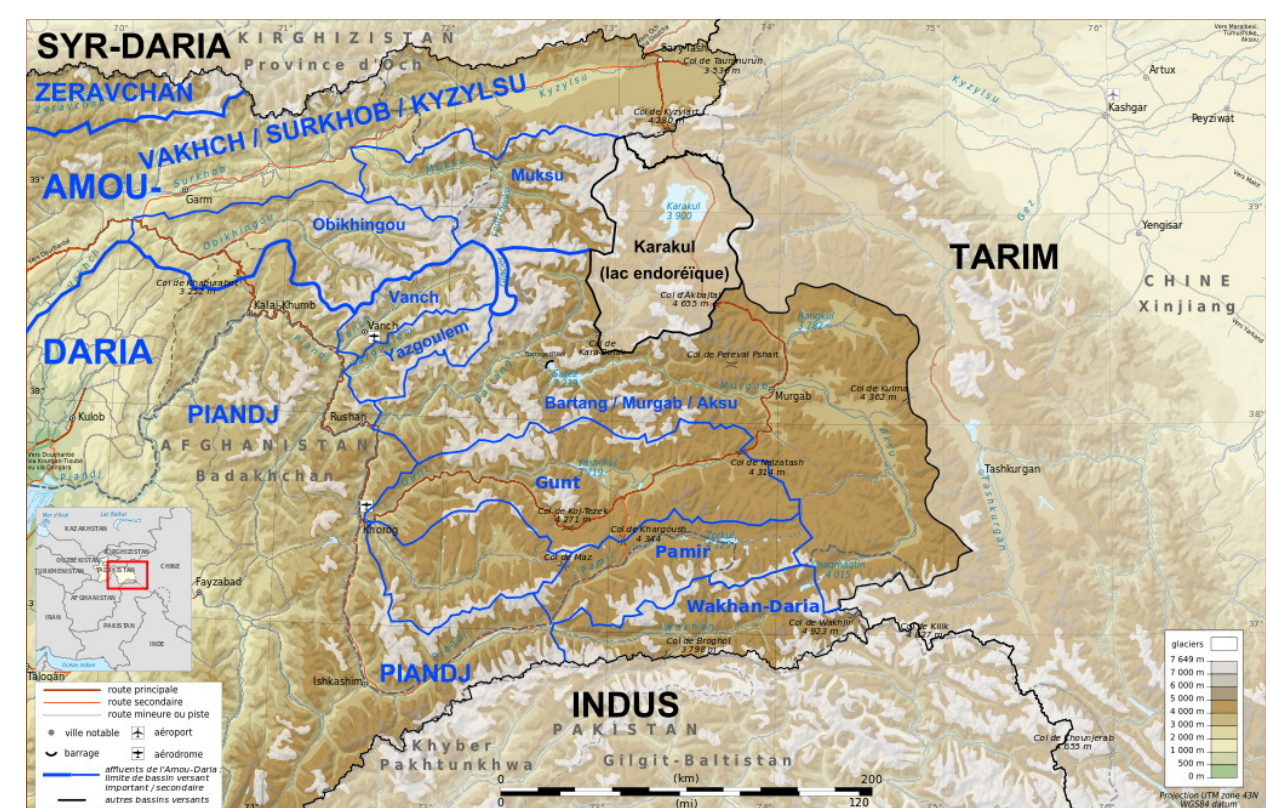
Figure 3. Gunt River Basin on Hydrological Map of the Republic of Tajikistan. Source: https://commons.wikimedia.org/wiki/File:Pamir_ drainage_basin_map-fr.svg, last access: 7 July